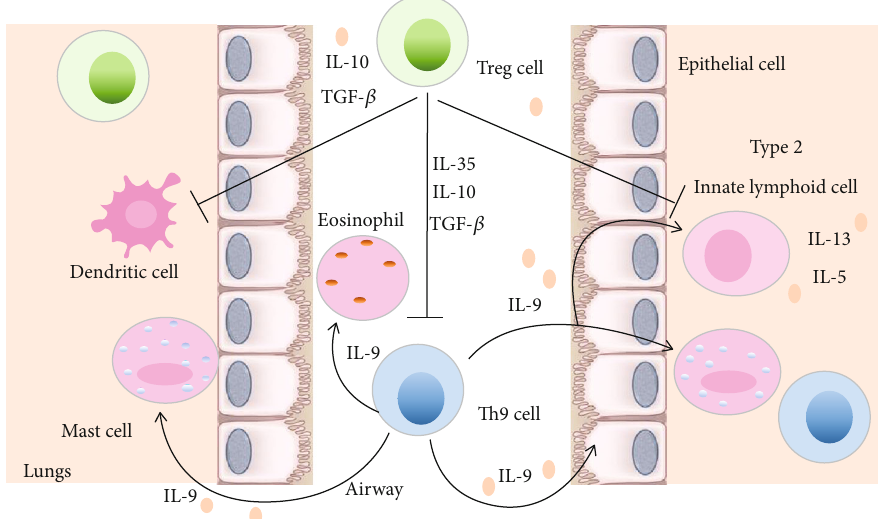
Figure 4: Th9 cells and Treg cells in allergic asthma. Th9 cells and IL-9 could promote activation and accumulation of mast cells (MCs), dendritic cells (DCs), type 2 innate lymphoid cells (ILC2s), and eosinophils, as well as production of IL-13 and IL-5 in asthma. Furthermore, IL-9 and Th9 cells can alter epithelial cell function and promote airway hyperresponsiveness (AHR), mucus hypersecretion, and airway collagen deposition. Inhibition of immune responses mediated by e ff ector T (Te ff ) cells and innate immune cells is a primary function of Treg cells in asthma. Treg cells restrain Th9 cell, DC, and ILC2 function in the lung, resulting in suppression of inappropriate immune responses. Treg cells also release inhibitory cytokines such as IL-10, TGF- β , and IL-35 to control allergic